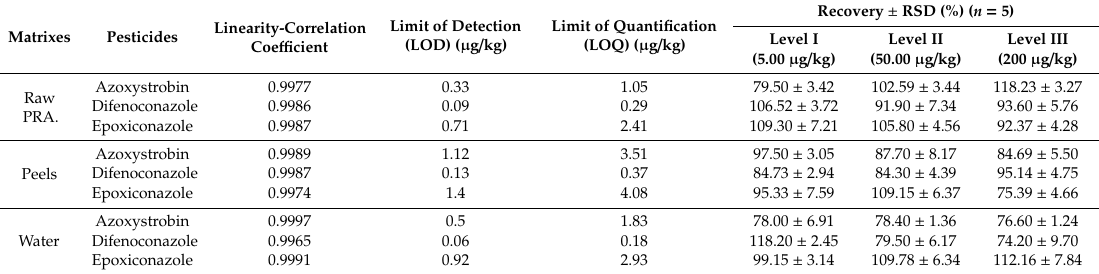
Table 3. Validation parameters for the UPLC-MS / MS determination of three pesticides in processed